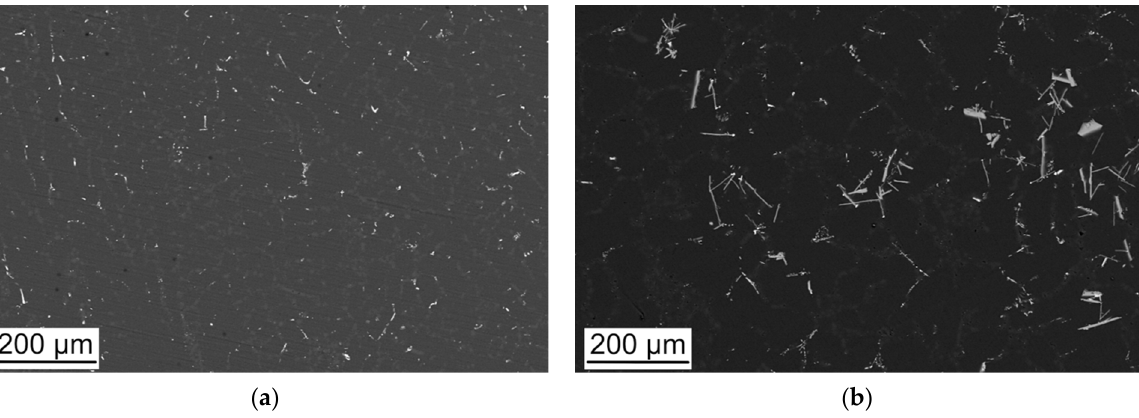
Figure 8. SEM BSE micrograph of E3 ( a ) and EZ35 ( b ) alloys after SHT for 5 h at 540 °C and aging for 100 h at 300 °C.